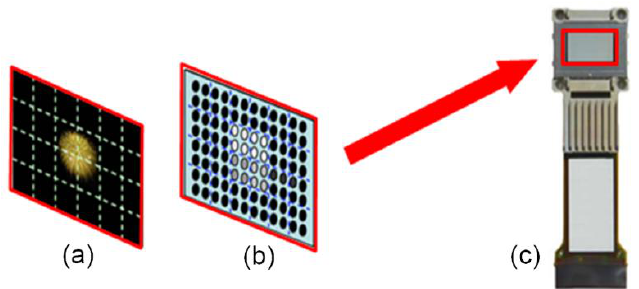
Figure 7. Design concept for generating the local dimming phenomenon on the imaging chip components. ( a ) Image, ( b ) local dimming, ( c ) LCD imaging chip.